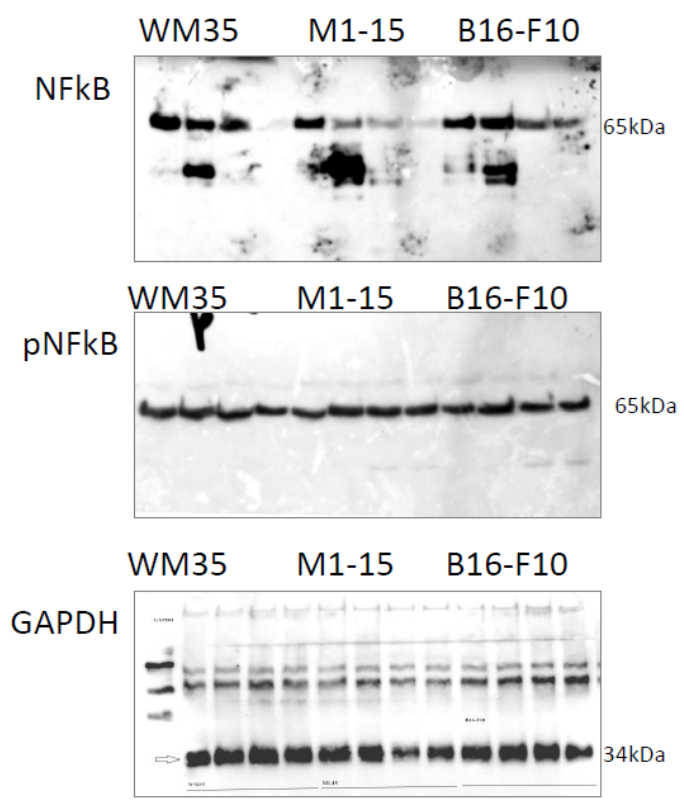
Figure A1. Original images WB Figure 4.